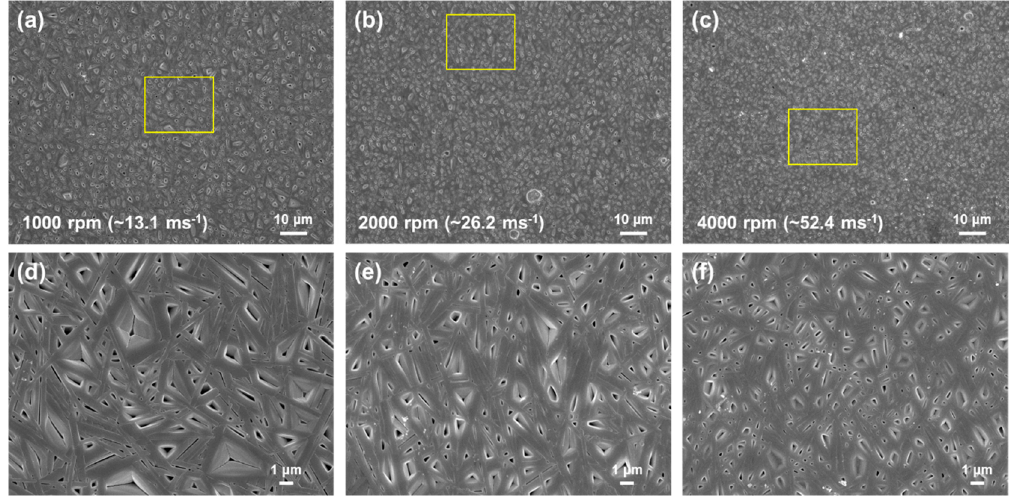
Figure 2. The SEM images of the free surfaces of ribbons with varying wheel rotation speed during the MS process: ( a , d ) 1000 rpm; ( b , e ) 2000 rpm; ( c , f ) 4000 rpm.